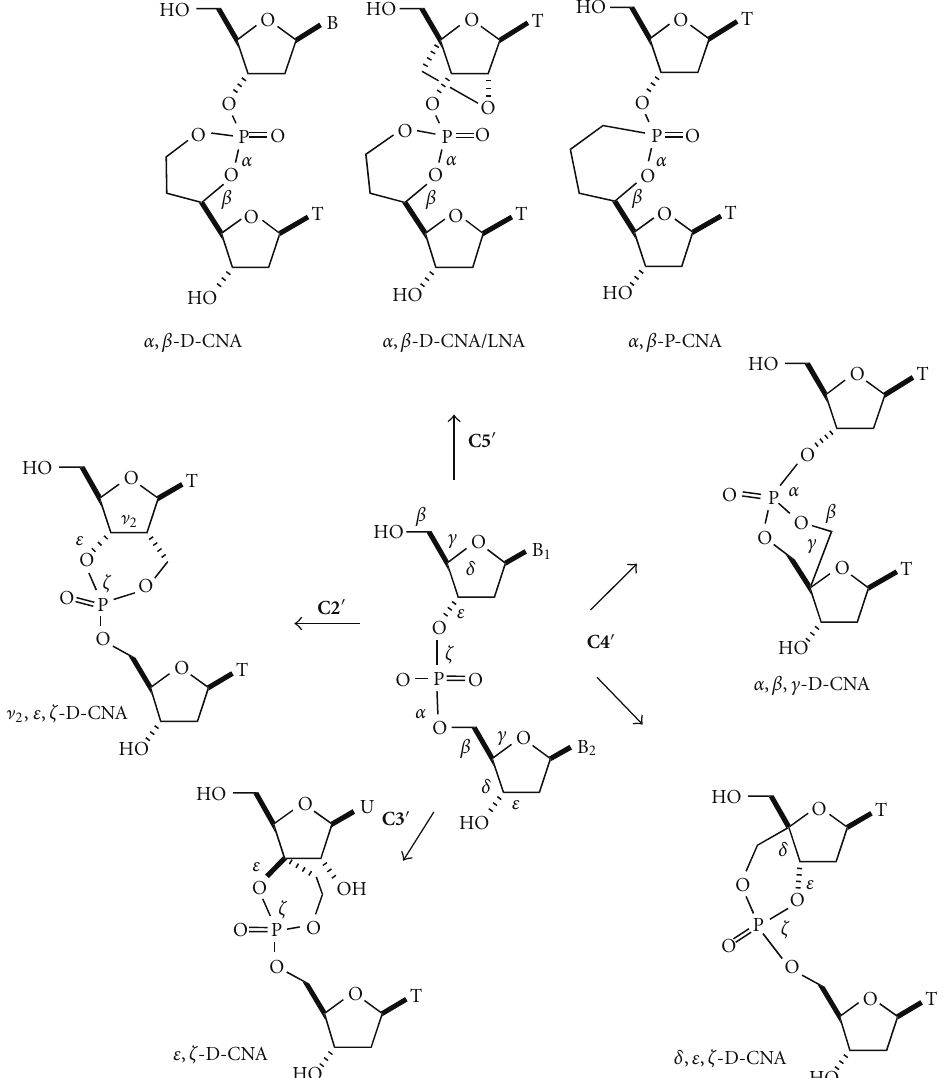
Figure 3: D-CNA dinucleotides building blocks for sugar/phosphate torsion angles